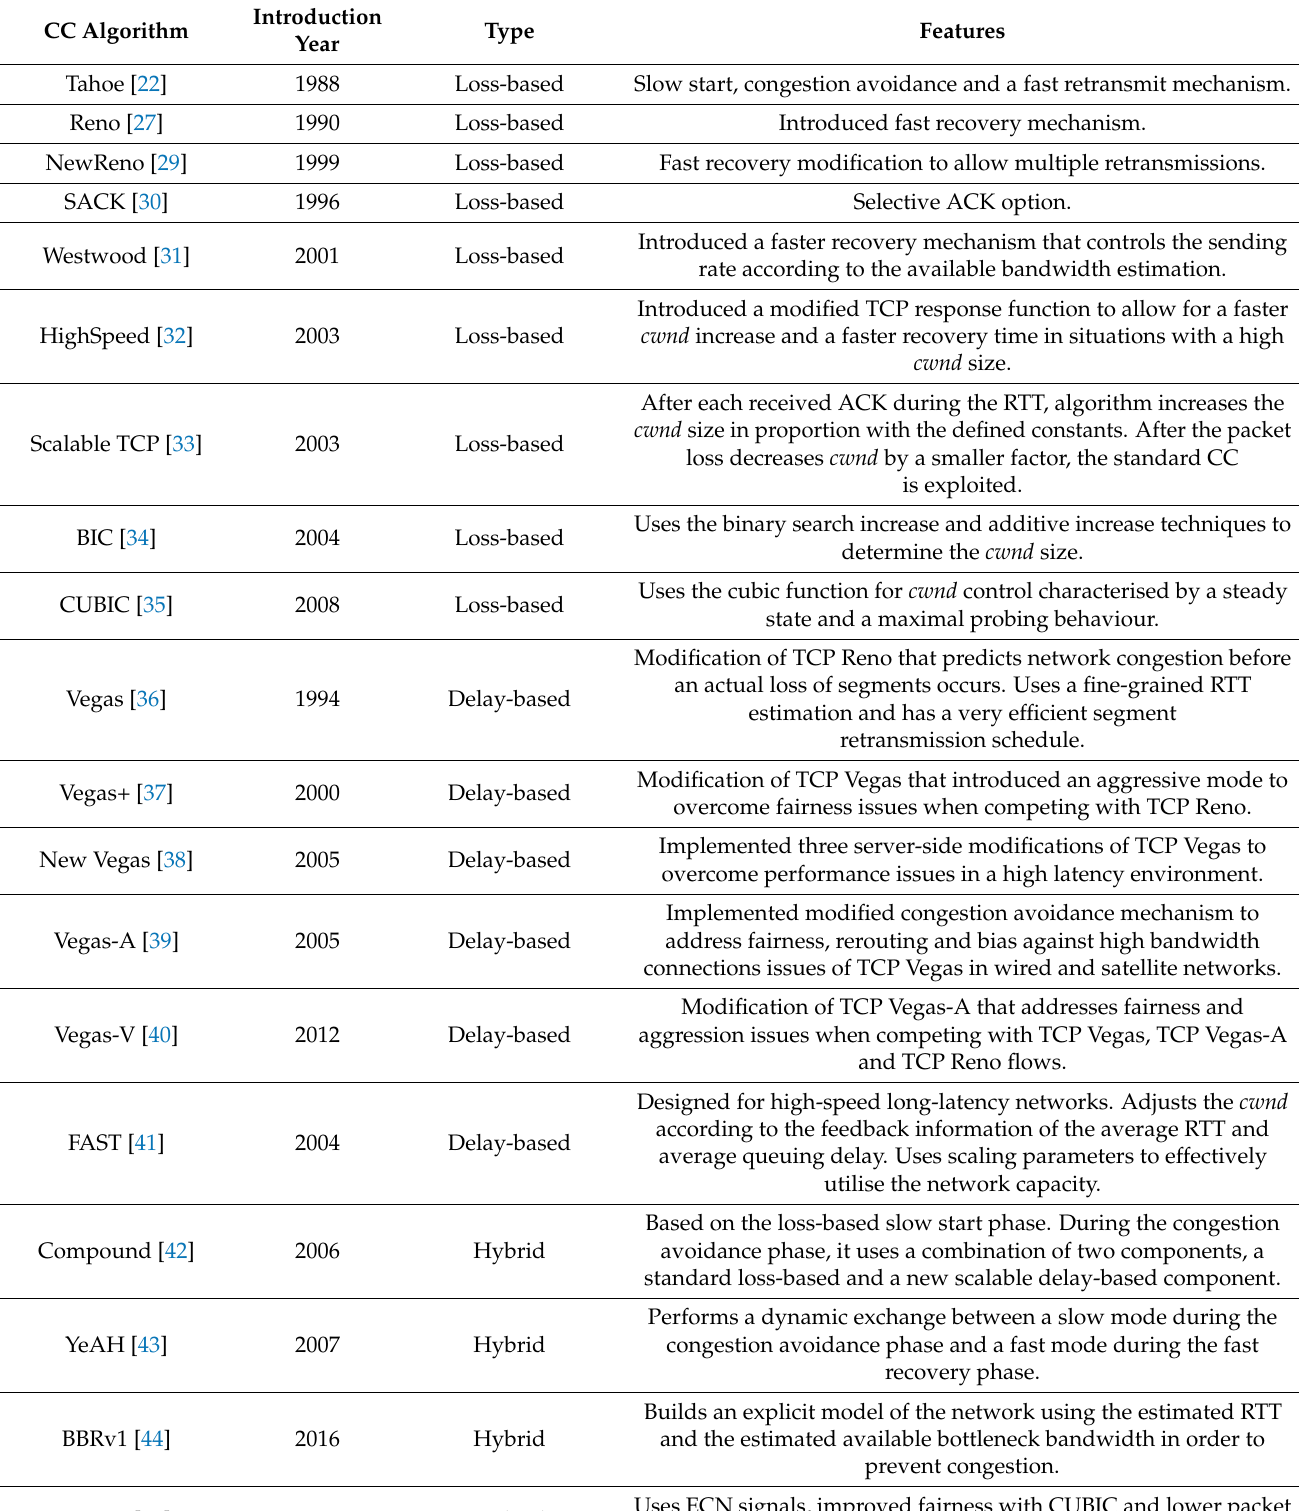
Table 1. Overview of the most relevant single-flow TCP CC